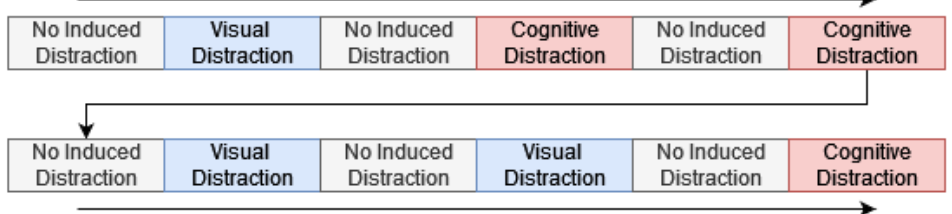
Figure 4. Experimental segments during study 1. Each segment took approximately one minute.